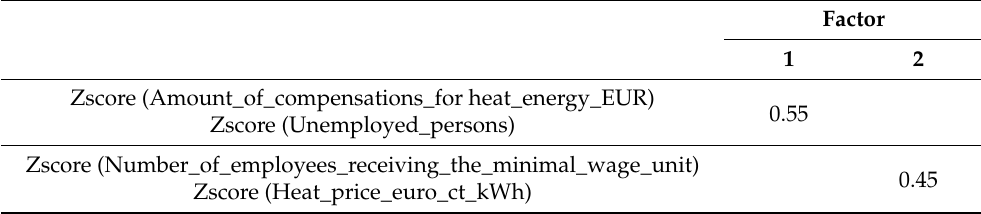
Table 10. Quadratic factor load (reduced to a single amount) for shadow economy risk indicators.